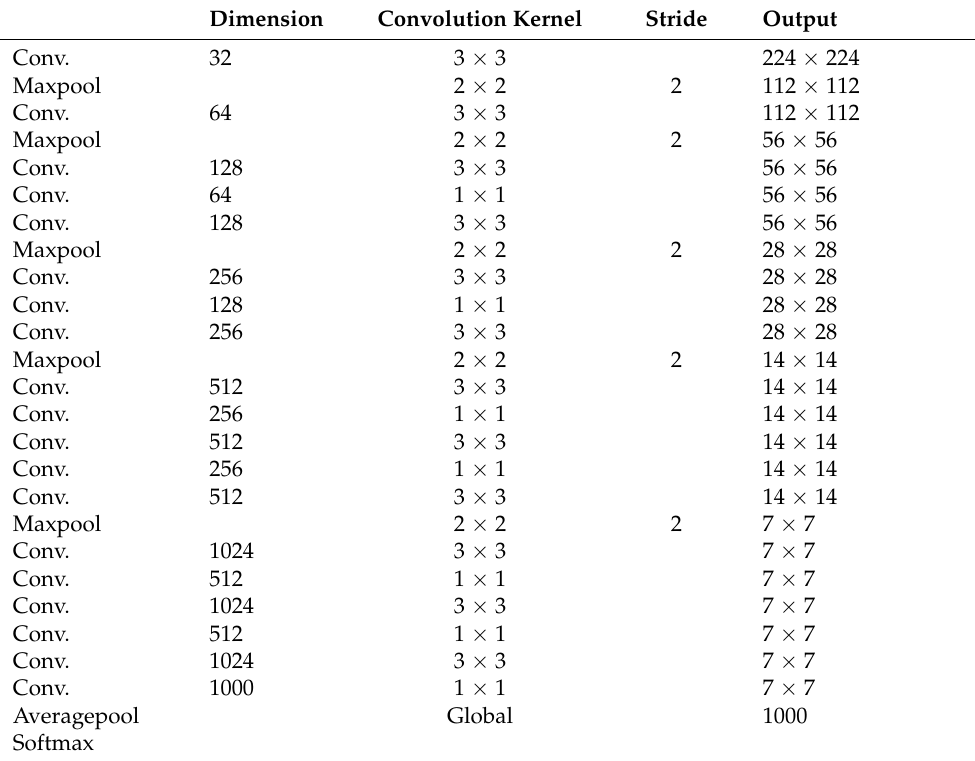
Table 1. The structure of DarkNet19. Dimension Convolution Kernel Stride